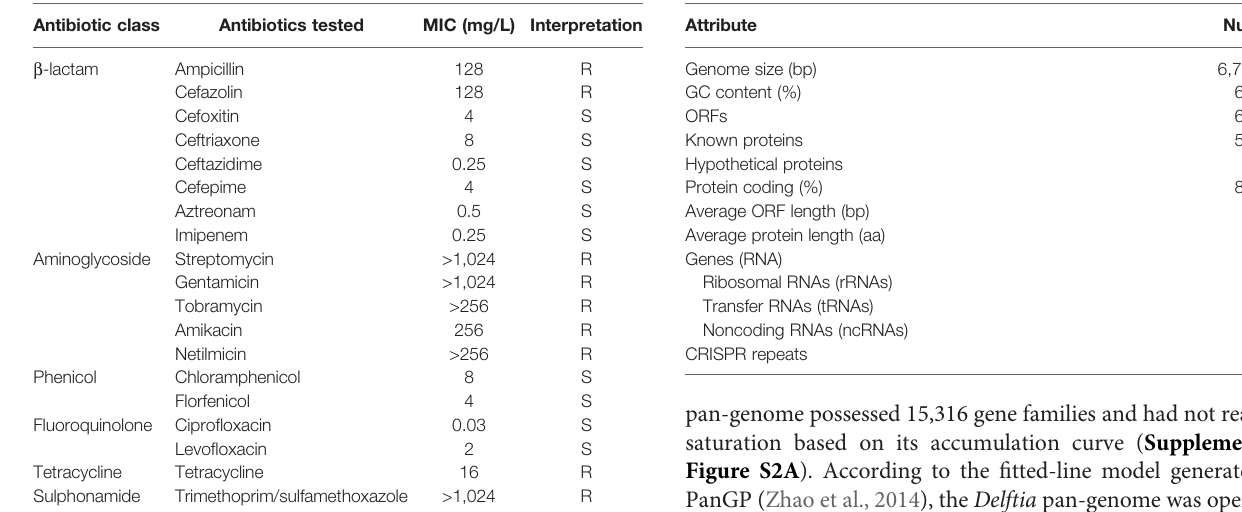
TABLE 1 | Antimicrobial susceptibility of D. tsuruhatensis strain TR1180. TABLE 2 | General features of D. tsuruhatensis TR1180